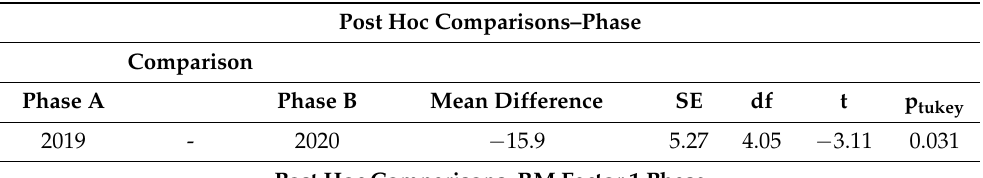
Table 4. Tukey post hoc comparisons between habilitation approaches and “type” of vocalization per